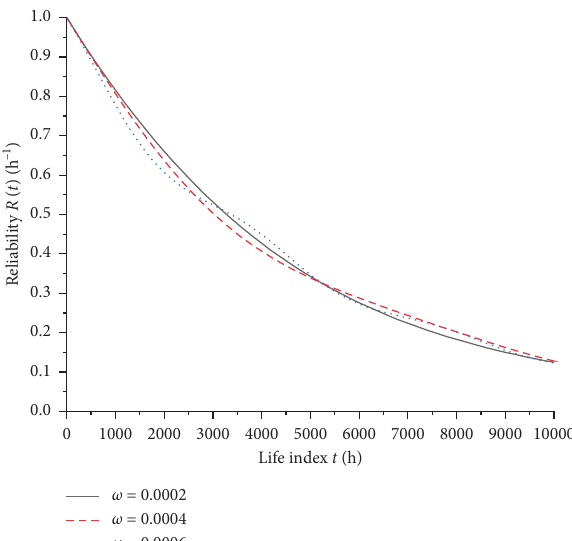
Figure 17: Effects of oscillating angular frequency on reliability.